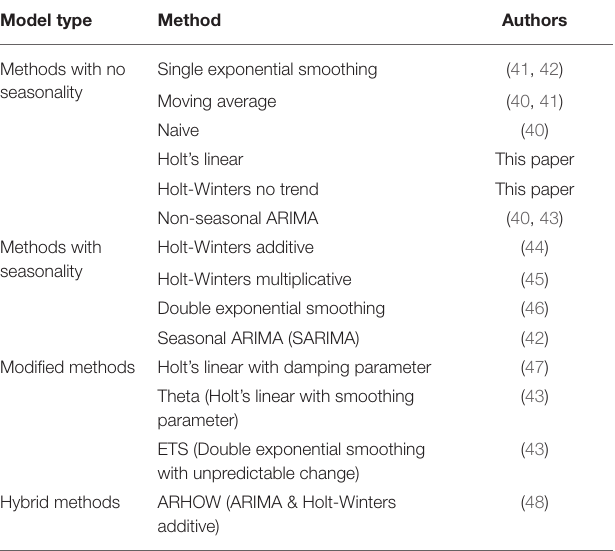
TABLE 1 | The summary of methods applied for drugs sales forecasting. Model type